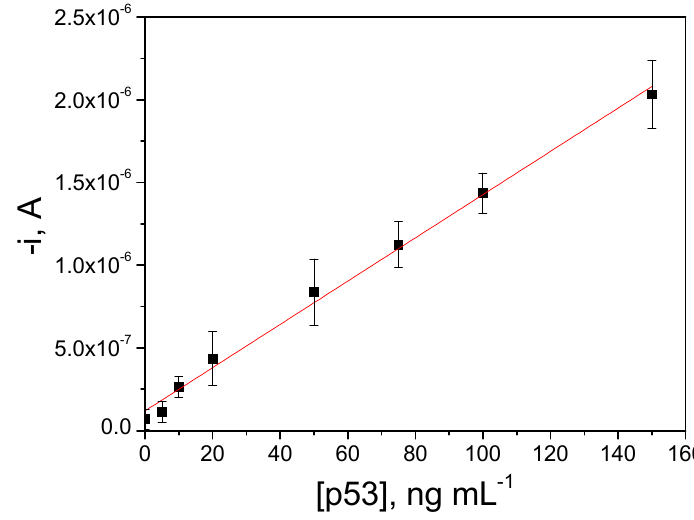
Figure 3. Calibration plot constructed with human p53 standards. Error bars were estimated as triple that of the standard deviation ( n = 3).